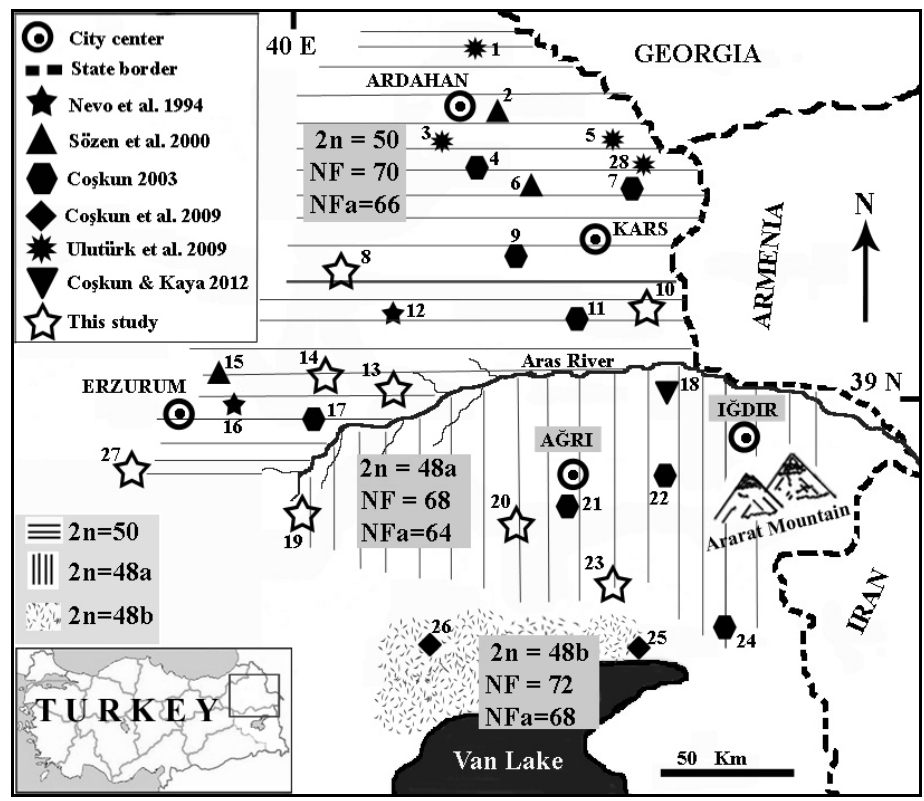
F IGURE 1 - Sampling localities and geographical distribution of chromosomal forms in the region.